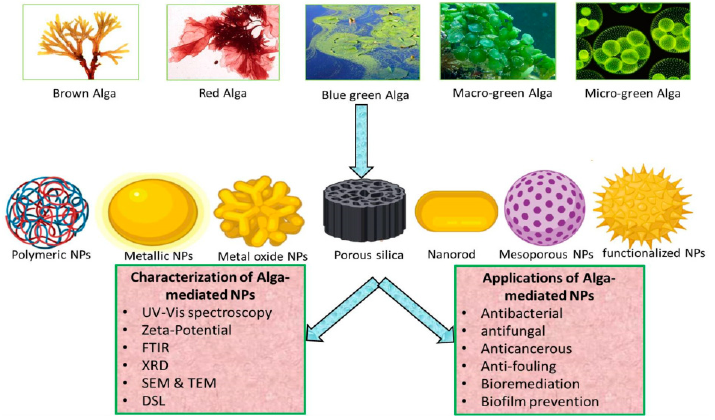
Figure 4. Algae-mediated synthesis of nanoparticles, their characterization, and applications. Copied from MDPI